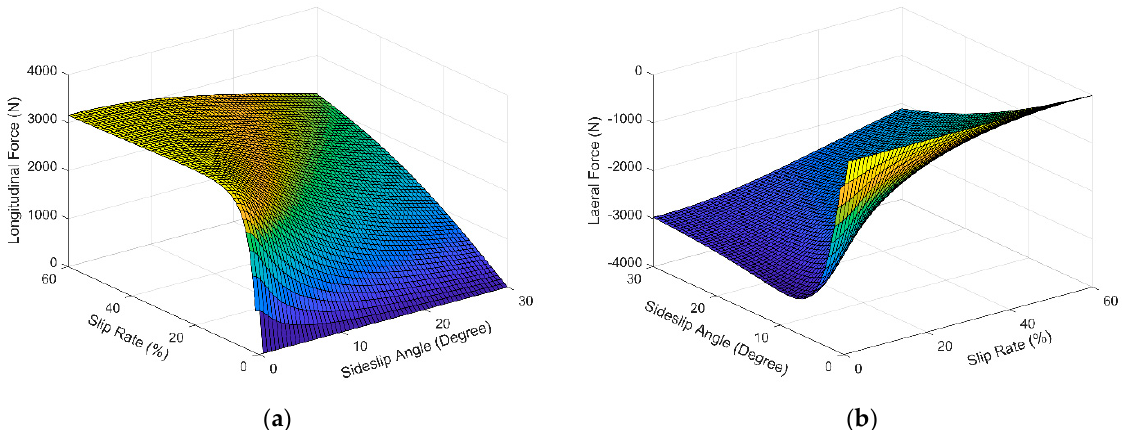
Figure 4. Longitudinal force and lateral force in combined slip circumstances; the slip rate is from 0 to 0.6, and the sideslip angle is from 0 ° to 30 ° . ( a ) Longitudinal force; ( b ) Lateral force.